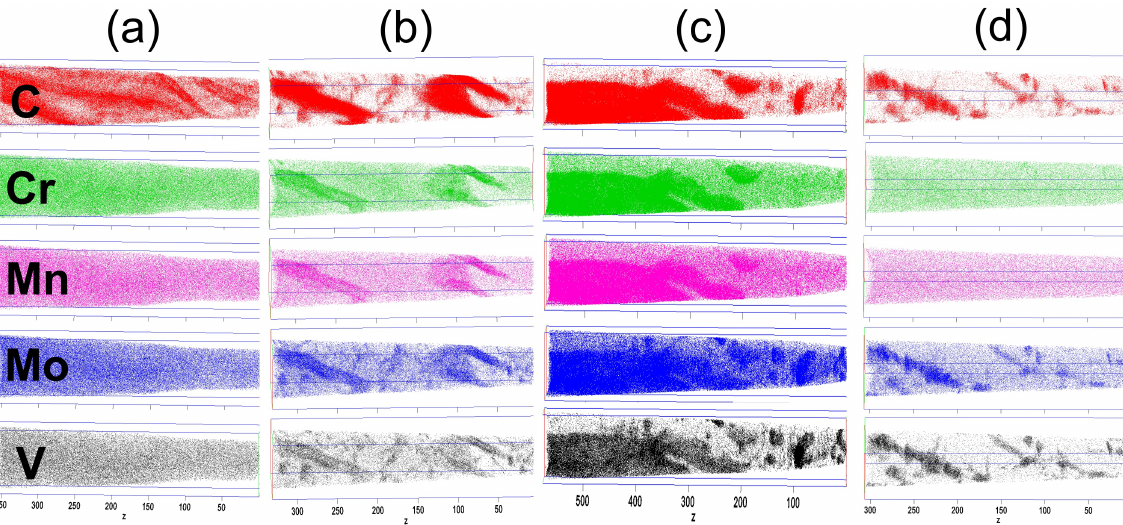
Figure 6. Results of three driving scenarios: no campaign, billboards, smart watch, for: ( a ) PncSL; Figure 7. APT results for material A tempered at 600 ◦ C. Distribution of C, Cr, Mn, Mo, and V after ( b ) PST; ( c ) AMS; and ( d ) AS. ( a ) quenching, ( b ) 0 h at 600 ◦ C, ( c ) 4 h at 600 ◦ C, and ( d ) 24 h at 600 ◦ C (axes in